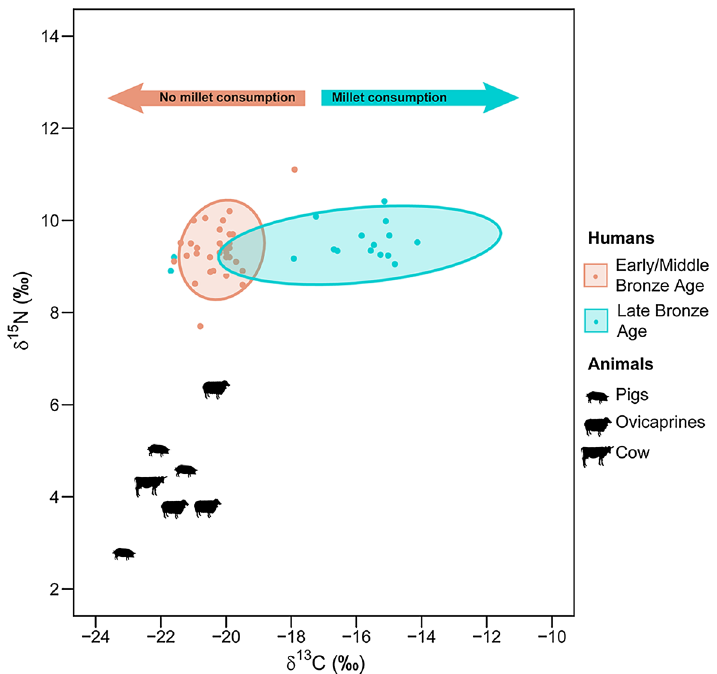
Figure 5. δ 13 C and δ 15 N values of bone collagen analysed from northern Atlantic Iberian Bronze Age sites, including humans and animals from El Espinoso (Late Bronze Age); and La Llana, Los Cinchos and La Fragua (Early/Middle Bronze Age) in this study. Cova do Santo, La Castañera, La Garma A, Santimamiñe (Early/ Middle Bronze Age) and Ondarre (Late Bronze Age) from previously published